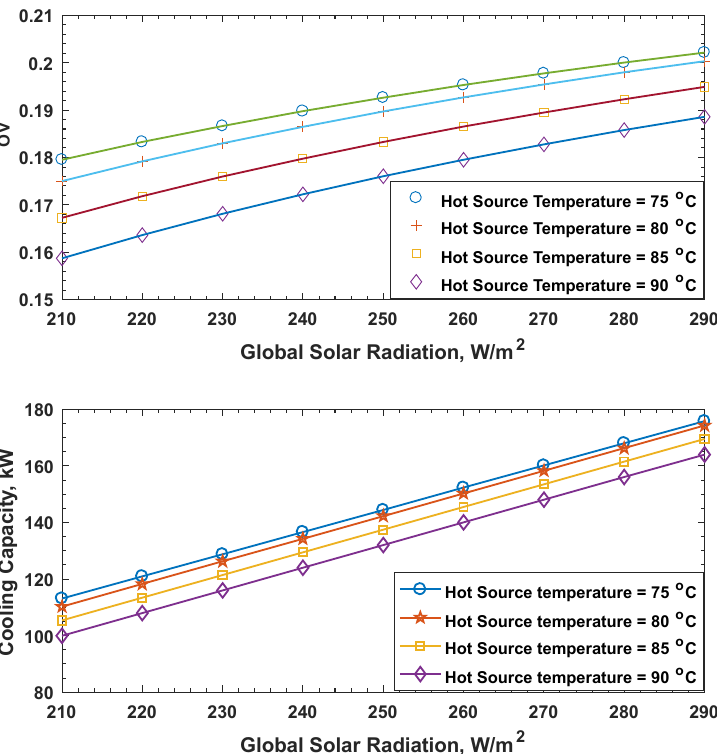
Figure 11. Effect of average global solar radiation on the performance of the overall system.